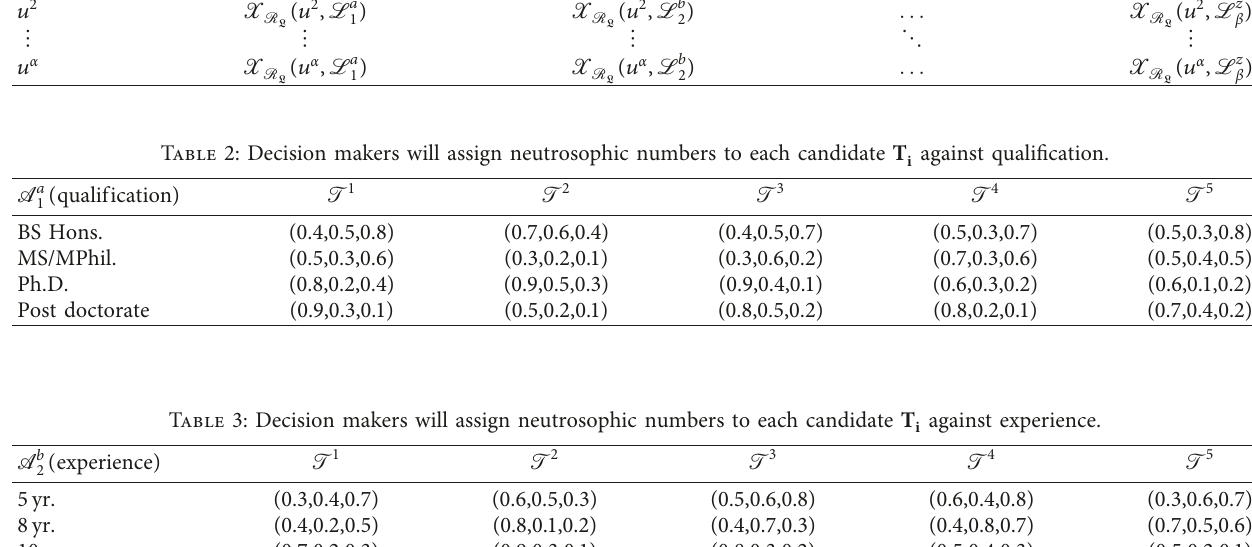
Table 1: Matrix representation of NHSS.